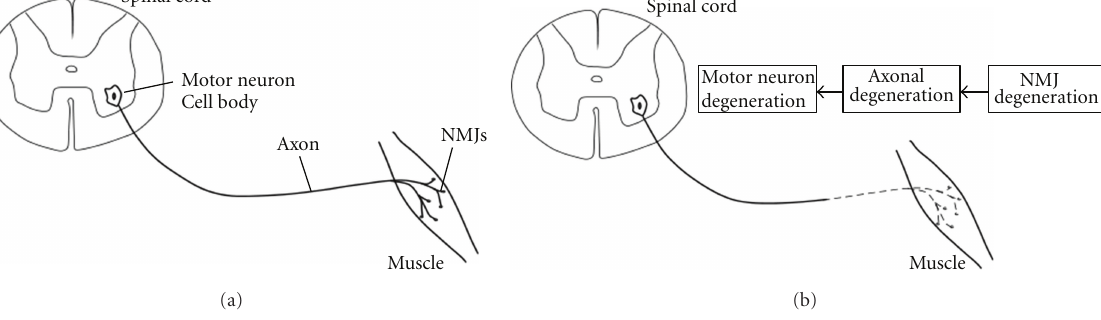
Figure 1: Schematic illustrating the “Dying-Back” hypothesis. (a) In a healthy system, communication and the transport of vital biomolecules occurs normally along the axon connecting MNs and the NMJs they innervate. (b) In ALS, a progressive distal to proximal degeneration occurs, described as “Dying-Back.” NMJ degeneration is followed by axonal degeneration and eventually MN degeneration.